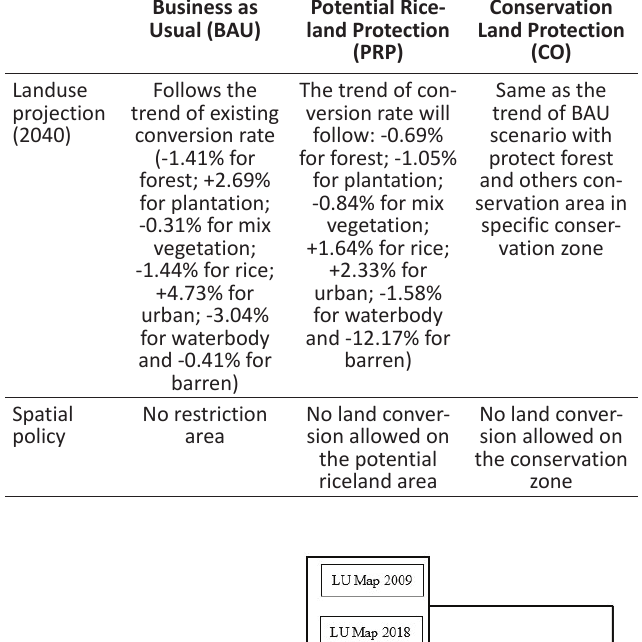
Table 2 . The scenario description for landuse projection in